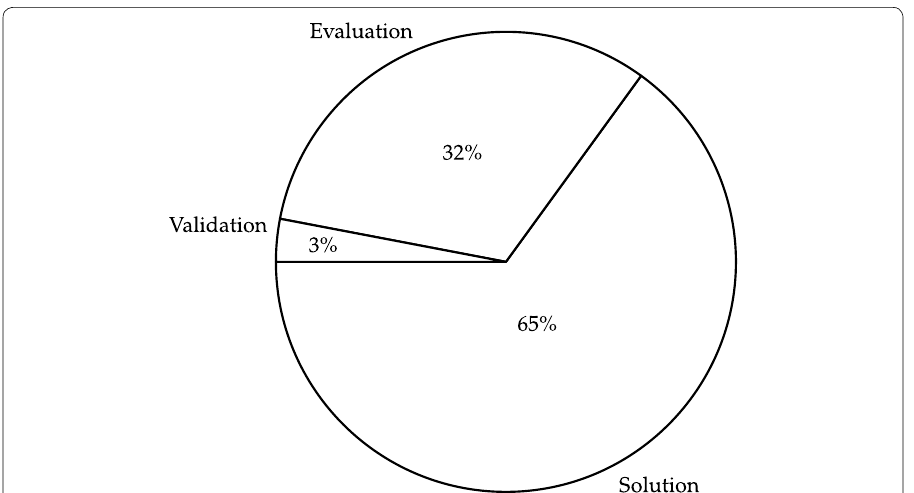
Fig. 3 Existing studies of feature selection methods in big genomic data analytics. The figure shows the results of the comparison between types of already existing studies, which shows that most research is oriented towards presenting solutions or evaluations of already existing solutions, supported by strong proof and experiments